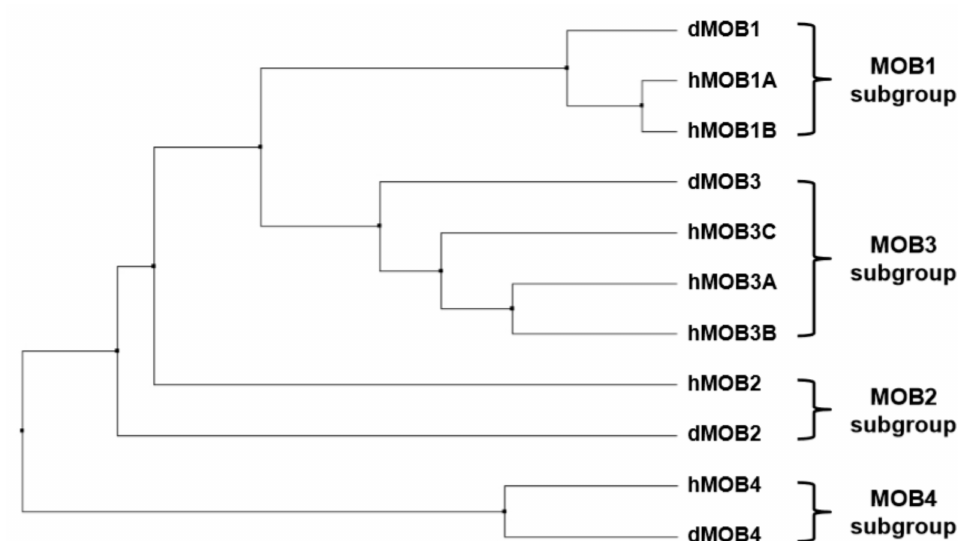
Figure 2. Phylogenetic relationships within the fly and human MOB protein family. The phylogenetic tree was defined using Clustal Omega (https: // www.ebi.ac.uk / Tools / msa / clustalo / ) together with the Jalview 2.10.5 software using phylogenetic calculation based on the neighbour-joining method. The UniProtKB nomenclature for the analysed proteins is defined in the legend of Figure